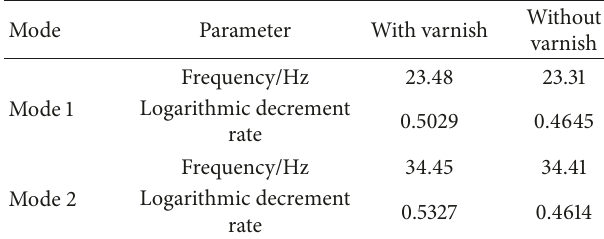
Table 3: Shaft model.